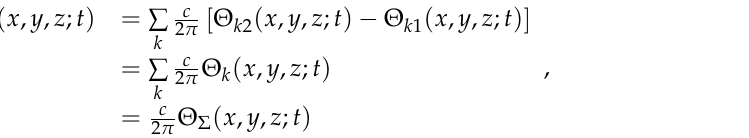
i and r i ; and ( b ) angles α i ( i =